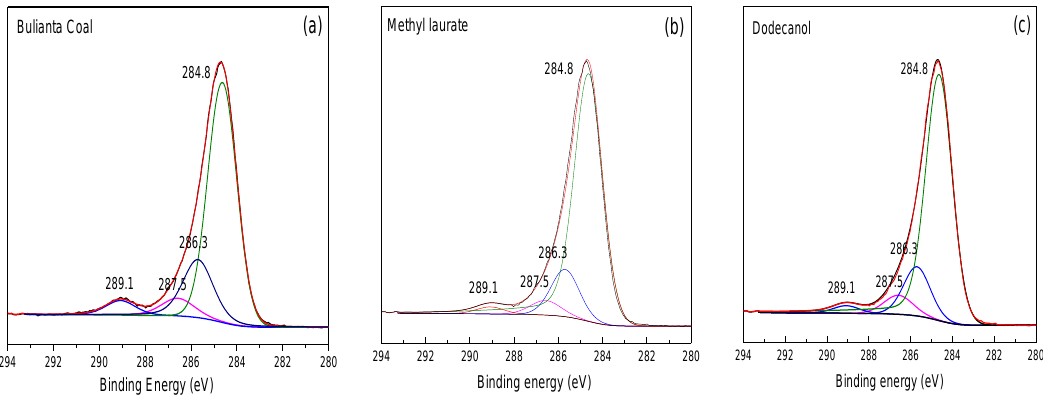
Figure 14. XPS C 1s spectrum of ( a ) raw coal, ( b ) the coal surface after the adsorption of methyl laurate, ( c ) the coal surface after the adsorption of dodecanol.